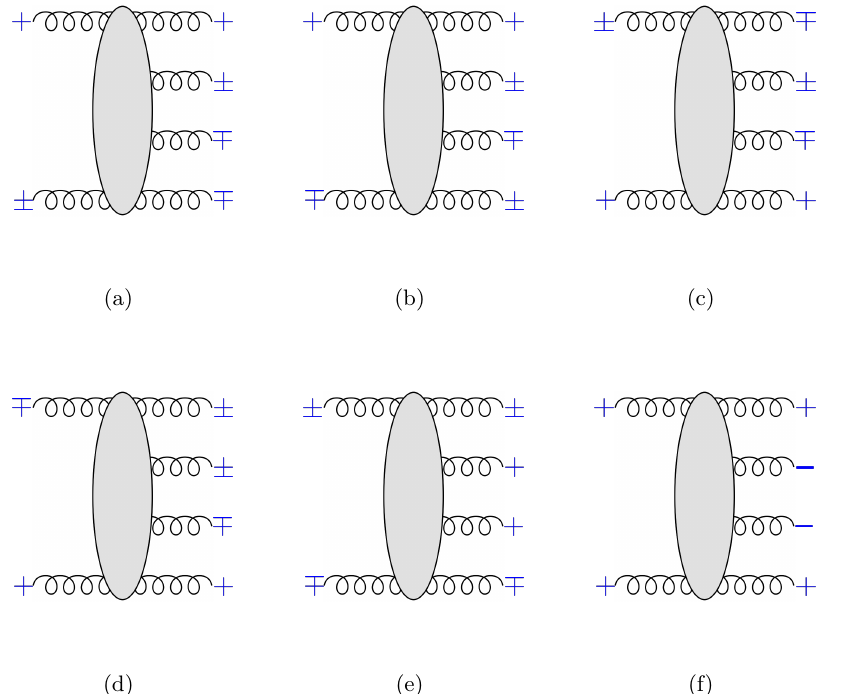
Figure 13 . Eleven of the MHV helicity configurations that are power suppressed in the central NMRK limit. The remaining eleven power suppressed MHV configurations can be obtained by flipping all helicities. The labelling of the gluons follows figure